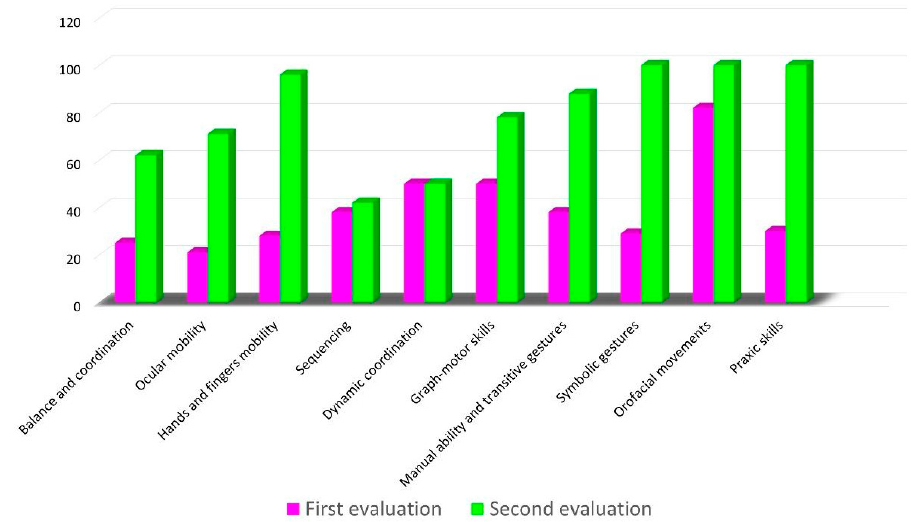
Figure 7. Dyspraxia-related aspects on active subjects. Comparison between first and second APCM-2 evaluations (average values on all five active subjects).